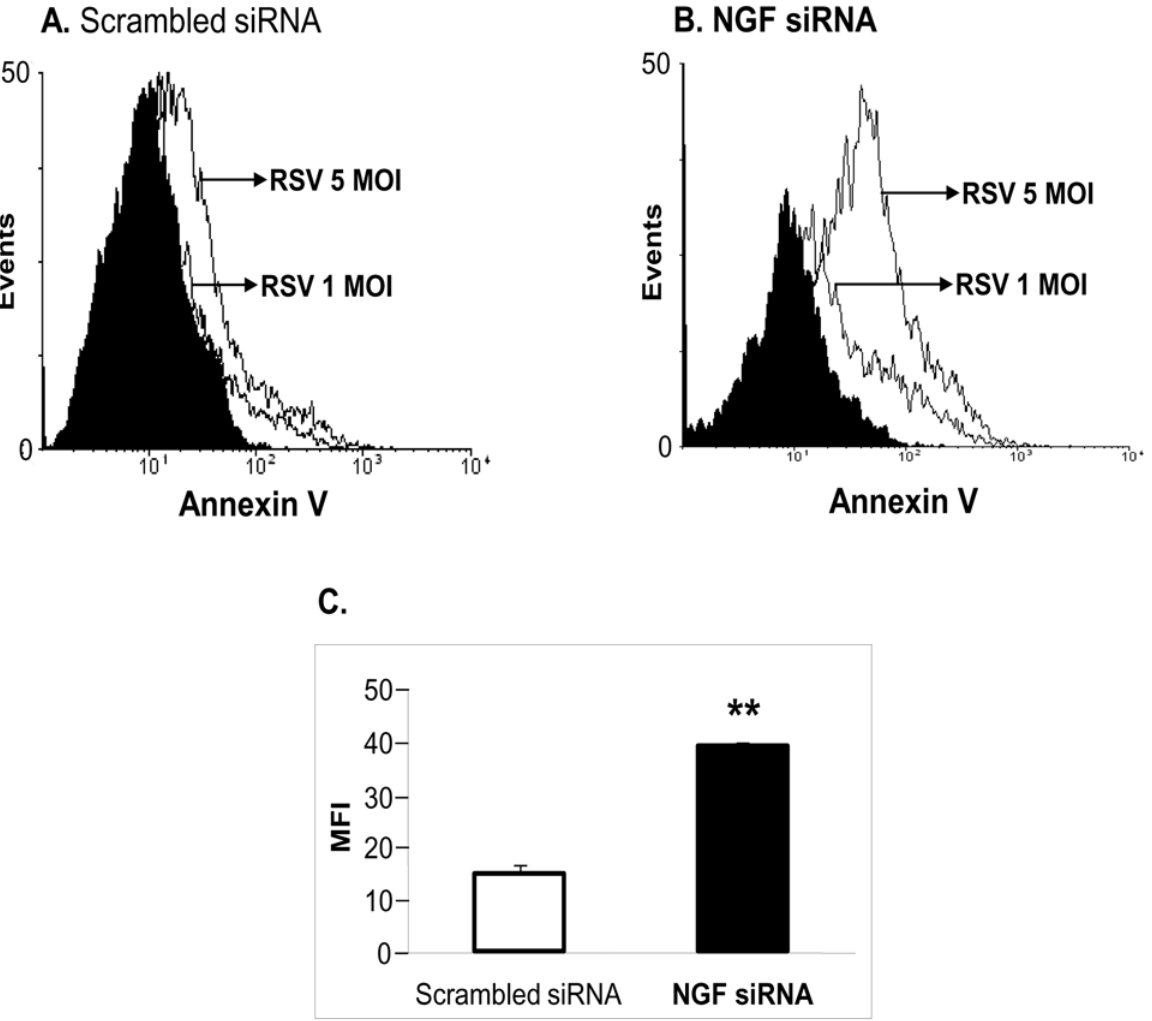
Figure 7. Apoptosis in RSV-infected bronchial epithelial cells increases after NGF knock-down. (A) Scrambled siRNA-transfected bronchial cells infected with 1 MOI or 5 MOI of rgRSV. (B) NGF siRNA-transfected bronchial cells infected with 1 MOI or 5 MOI of rgRSV. After 24 h of infection, cells were analyzed for apoptosis by flow cytometry with annexin V PE-conjugated antibody. The shaded portions of the histograms represent matched isotype controls. (C) Geometric mean fluorescence intensity (MFI) in NGF-depleted cells infected with 5 MOI of rgRSV was compared with the scrambled siRNA control. Values were subtracted from the isotype MFI and presented as mean 6 SEM (n=4 experiments). **= p , 0.01 compared to controls transfected with scrambled